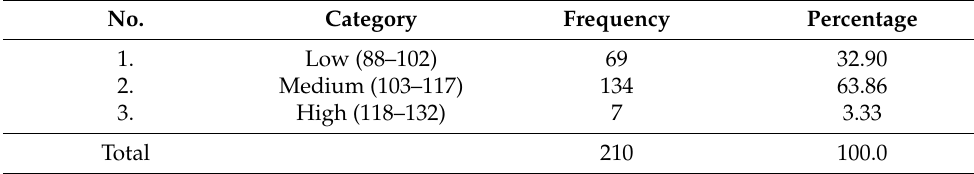
Table 4. Distribution of MSME actors in agriculture based on perceptions of their business. No. Category Frequency Percentage 1. Low (88–102) 69 32.90 2. Medium (103–117) 134 63.86 3. High (118–132) 7 3.33 Total 210